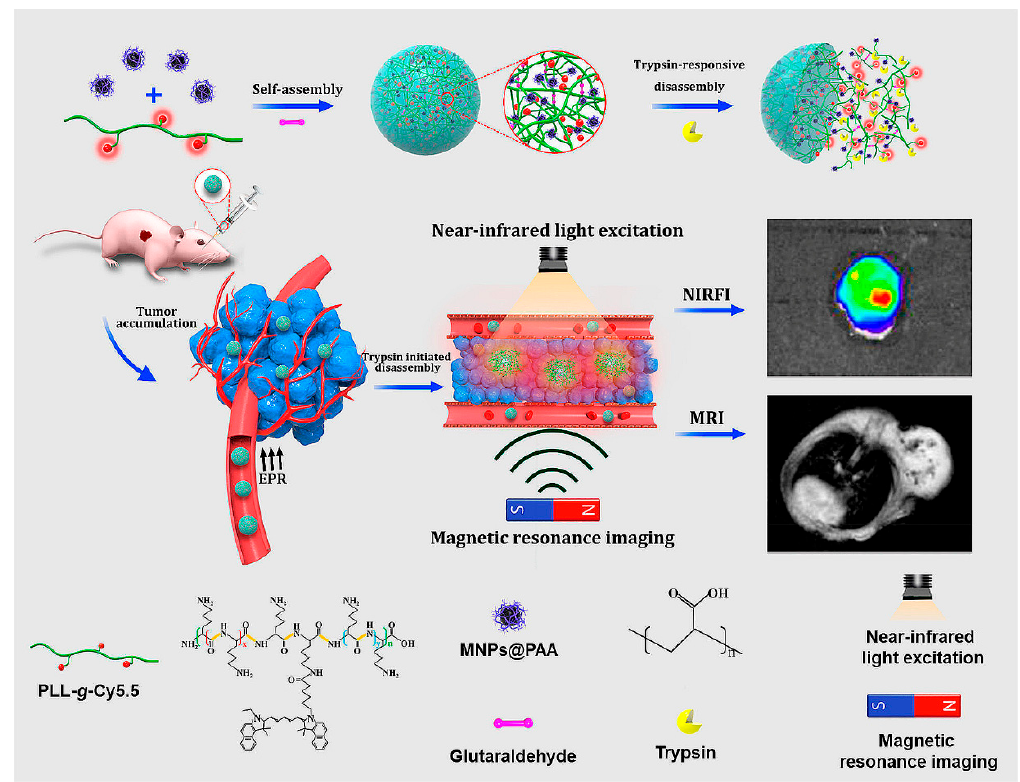
Figure 21. Self-assembly and trypsin-initiated disintegration of the nanoparticles for trypsin mapping of malignant tumors via NIR fluorescence and MR dual imaging. Adapted from [202], with permission. Copyright: 2020 American Chemical Society.